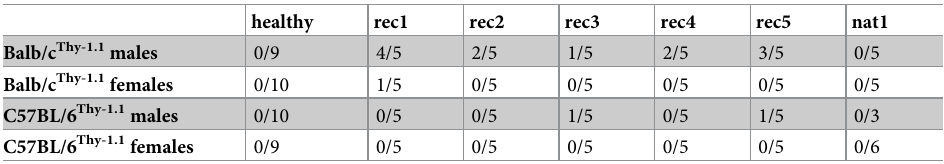
Table 3. FSGS plasma induced proteinuria mostly in Balb/c Thy-1.1 males. healthy rec1